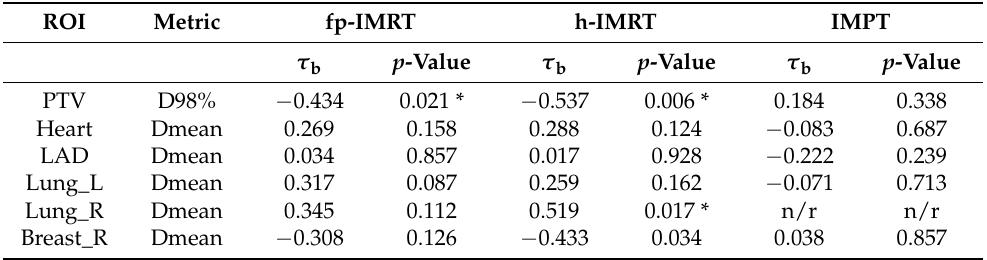
Table 4. Correlation between breast size (CTV volume, cm 3 ) and radiation dose to ROIs, n = 16.